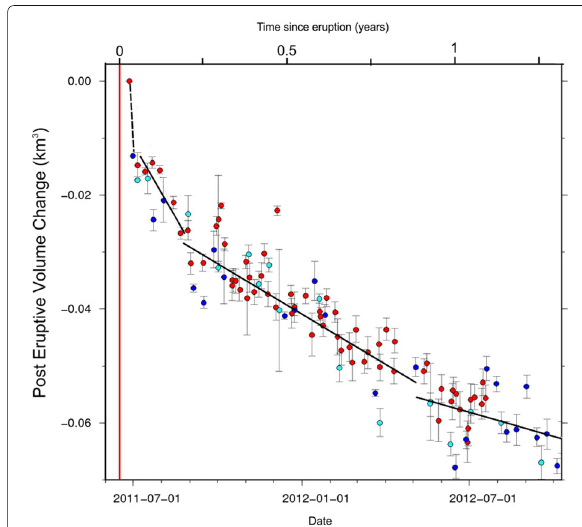
Fig. 6 Time series of volume change. Time is given in date (bottom) and years since the eruption started (top). The beginning of the eruption is indicated by the red line. Assuming a fixed geometry, a Mogi source at a depth of 6.4 km at 41.69° (long) 13.36° (lat). Black lines indicate the best-fit displacement rates, highlighting the non-linearity of the subsidence; the dashed line shows the jump at the start of the time series. CSK data is shown in red, TSX descending in blue and TSX ascending in light